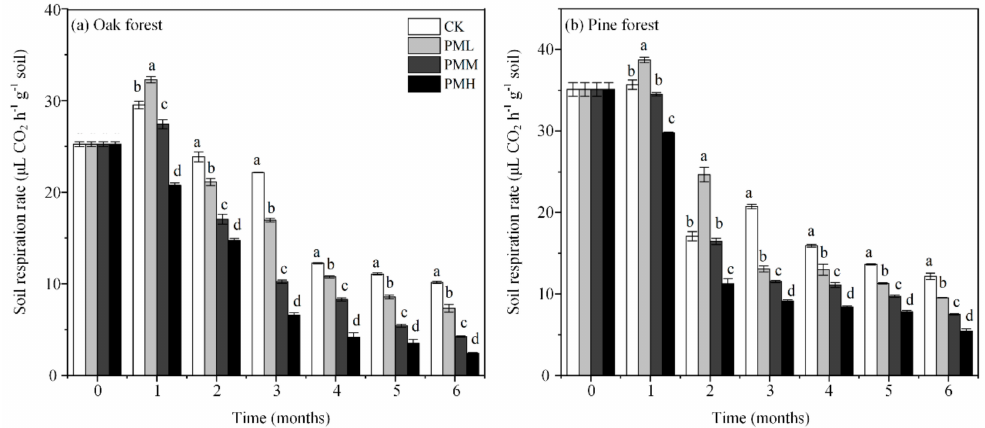
Figure 4. E ff ects of WSII–PM 2.5 exposure on substrate-induced respiration (SIR) in the (a) oak and (b) pine forests during six-months of leaf litter decomposition. Error bars indicate standard error ( n = 4). Bars with di ff erent lowercase letters are significantly di ff erent at p < 0.05. Abbreviations: CK—control; PML—low concentration WSII–PM 2.5 ; PMM—medium concentration WSII–PM 2.5